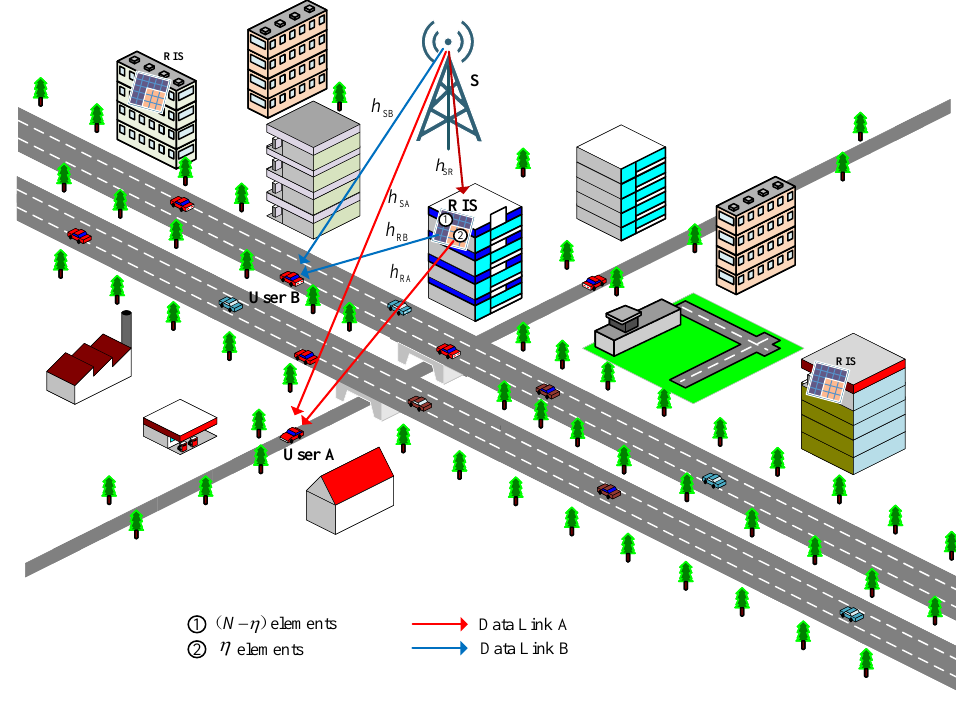
Figure 1. RIS intelligent allocation elements service a multi-user